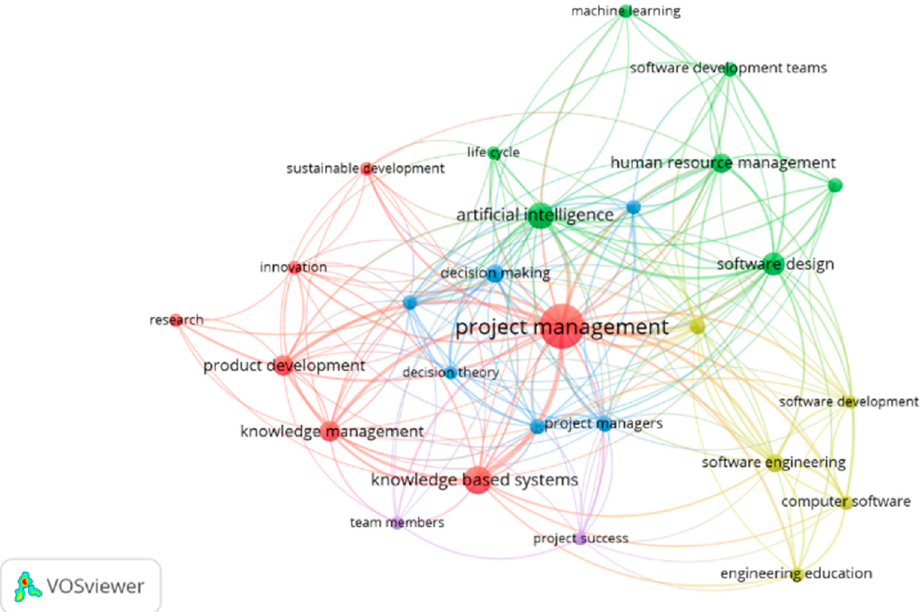
Figure 5. Clusters identified in the Team domain.